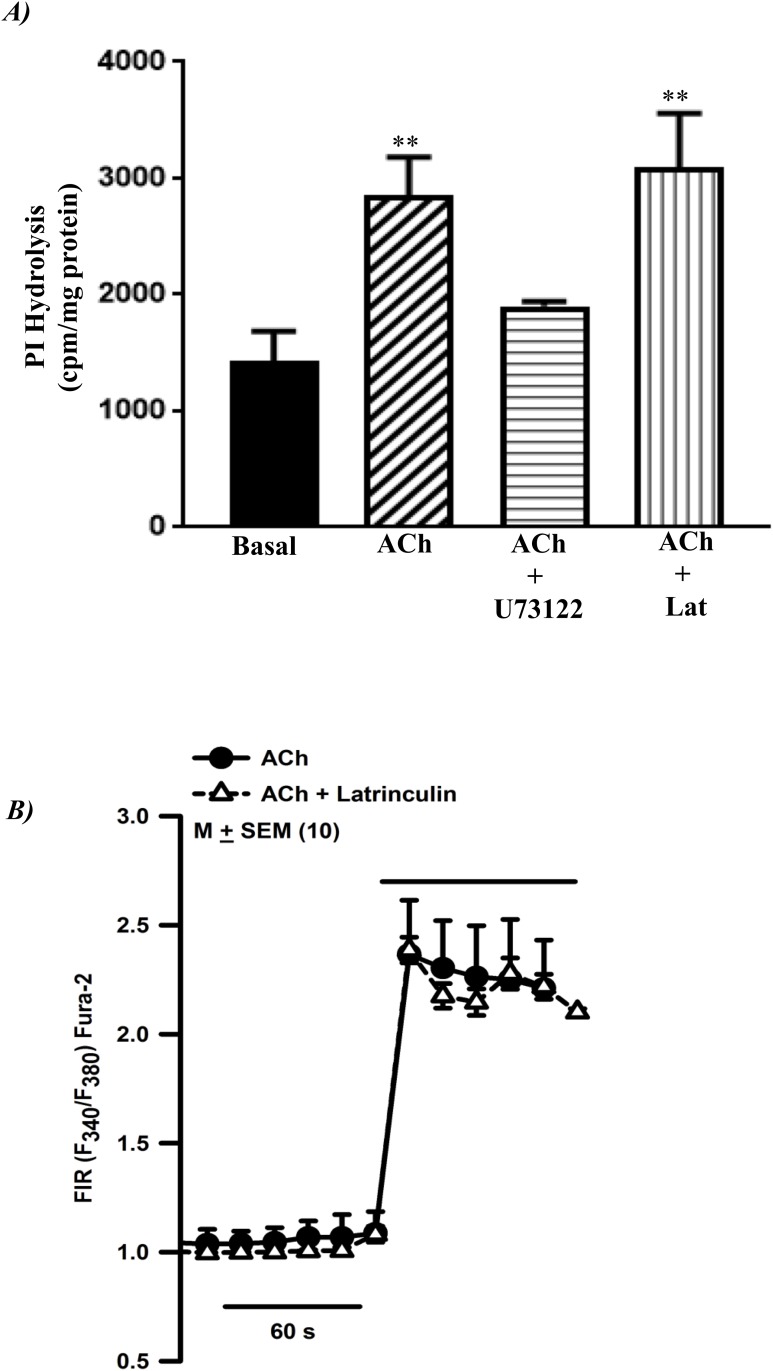
Lack of effect on phosphoinositide (PI) hydrolysis and [Ca2+]i by actin polymerization inhibitors.A: PI hydrolysis in response to ACh was measured in muscle cells labeled with myo [3H] inositol. Cultured smooth muscle cells were pretreated with the PLC-β inhibitor U73122 (10 μM for 10 min) or, the actin polymerization inhibitor latrunculin (1 μM, 1 h) followed by 1 μM ACh for 1 min, and PI hydrolysis was measured as an increase in water-soluble [3H] inositol formation. PI hydrolysis is expressed as [3H] inositol phosphate formation in counts per minute (cpm) per mg protein. B: Isolated smooth muscle cells were loaded with 5 μM fura-2 and treated with 1 μM ACh in the presence or absence of the actin polymerization inhibitor latrunculin (1 μM, 1 h). The cells were alternately excited at 380 nm and 340 nm. Results are expressed as a 340/380 ratio, and an increase in ratio reflects an increase in cytosolic Ca2+. Values are means ± SE of ten cells. **P<0.001.